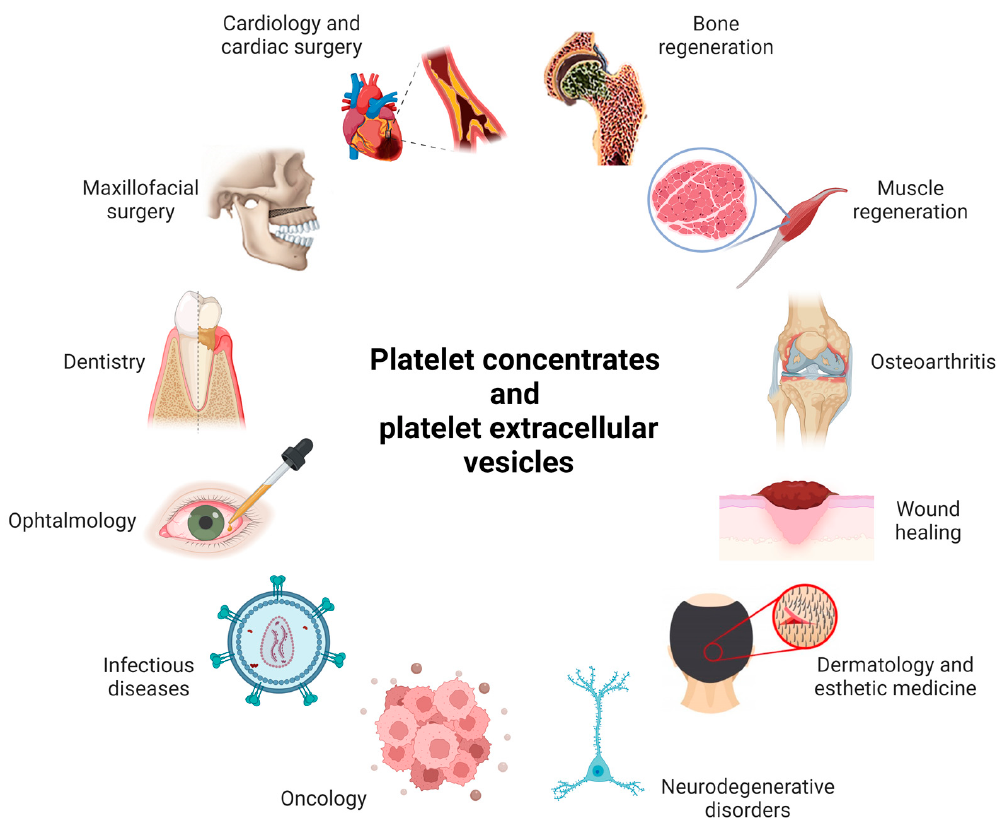
Figure 2. Main applications of platelet derivatives. Created in BioRender.com (accessed on 16 January 2023).